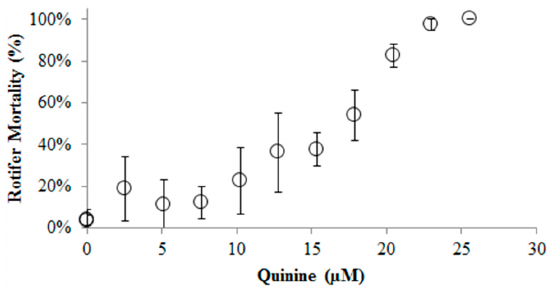
Figure 1. Effect of quinine sulfate on B . calyciflorus . (Circles stand for the rotifer mortality at different quinine sulfate concentrations).